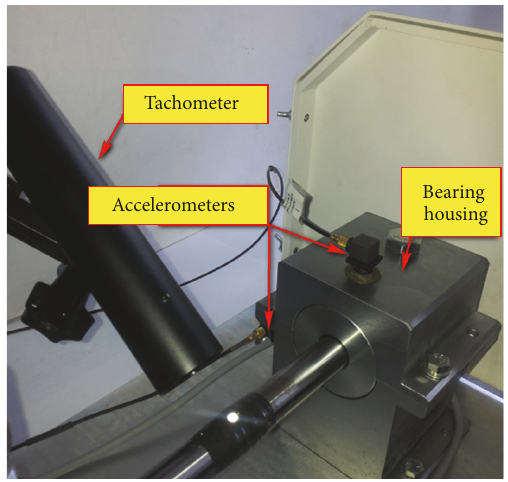
Figure 7: Part of the test rig with accelerometers DeltaTron 4507 and the contactless tachometer M0024